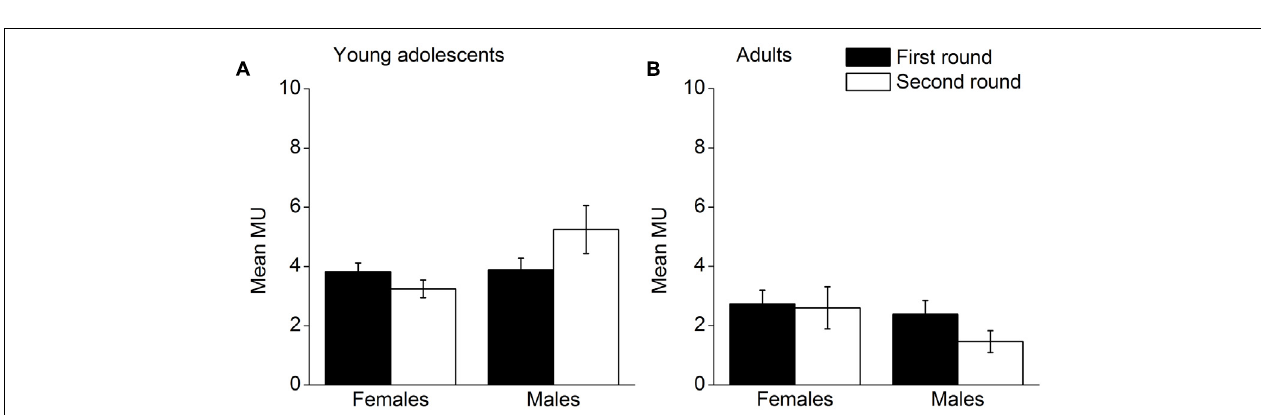
FIGURE 1 | Altruistic behavior in the two rounds for each age group; (A) mean MUs allocators shared, (B) mean MUs punishers used. Error bars represent standard error.